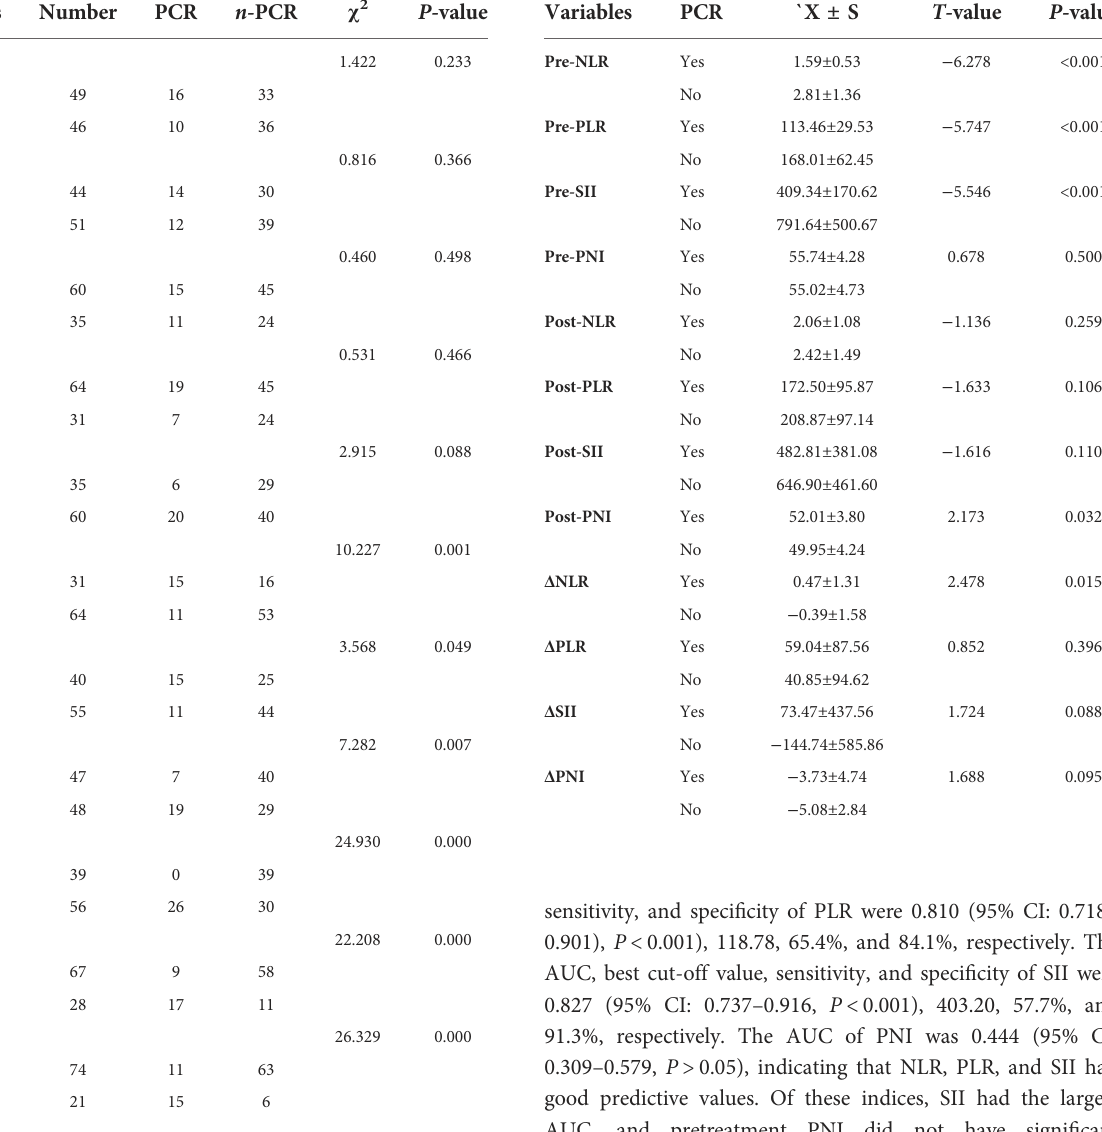
TABLE 1 Associations of clinicopathological characteristics with pCR in breast cancer patients.